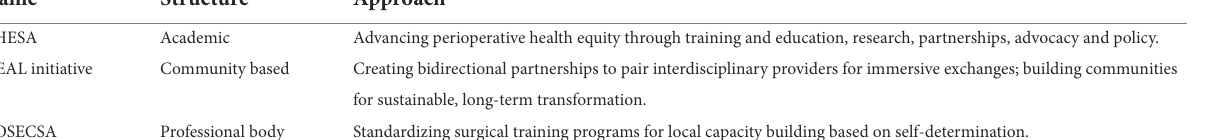
TABLE 1 Table of novel global health programs.